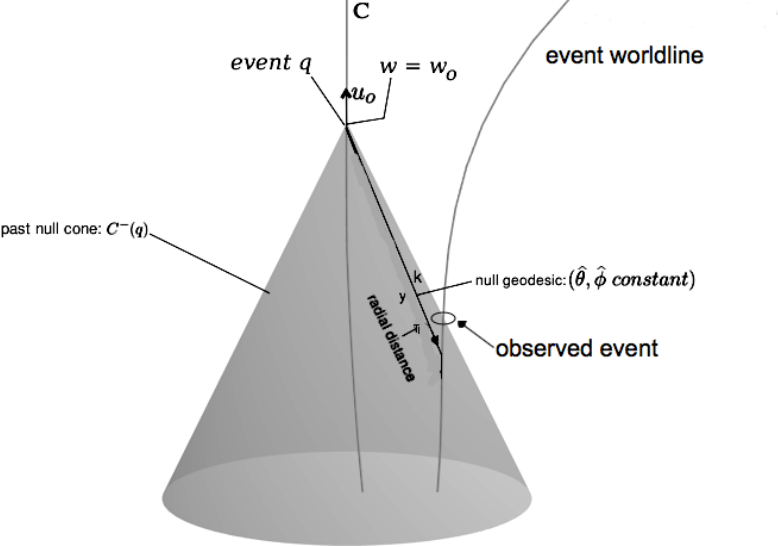
Figure 1. Observational coordinates { w , y , ˆ θ , ˆ φ } based on the event q on the worldline C . w is the time of observation; ˆ θ , ˆ φ represent the direction of observation; and y is a measure of distance to the object